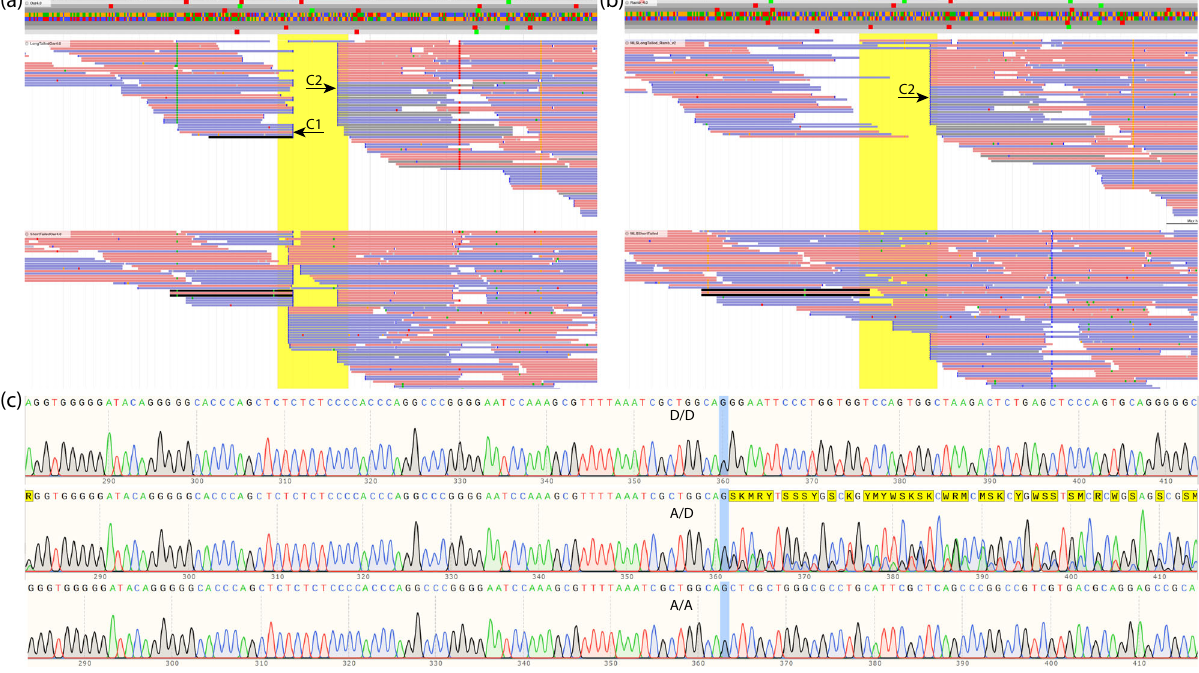
Fig. 3 Screenshots showing insertions, position of the candidate SNP at position 37,290,631 on OAR11, and extracts from ab1 trace fi les from Sanger sequencing. a Reads of the pooled sequenced long-tailed (above) and short-tailed (below) Merinolandschaf lambs mapped on assembly Oar_4.0, note the two clusters, cluster one (C1) is likely due to an assembly problem, cluster two (C2) represents an insertion shown in 34 of the 35 reads in the long-tailed group and in 13 of the 54 reads in the short-tailed group; b shows the same groups mapped against the newest assembly ARS-UI_Ramb_v2.0, note the disappearance of C1; c Sanger sequences for one homozygous derived (D/D), one heterozygous (A/D) and one homozygous ancestral (A/A) lamb around 40 bp before and after the breakpoint of the real